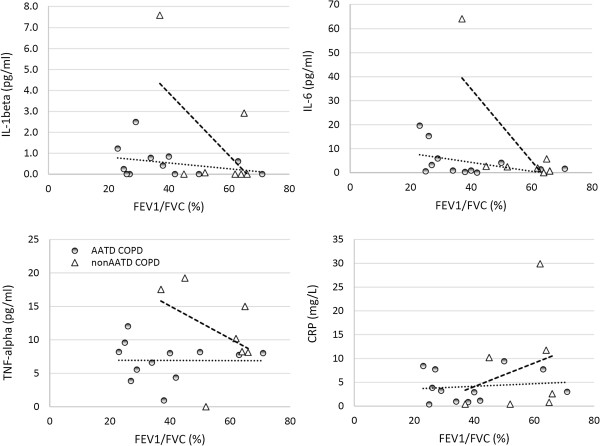
Correlation between circulating arterial cytokines and airway obstruction for AATD COPD patients (i.e. AATD + AUG and AATD-AUG groups shown as shaded circles) and for non-AATD COPD patients (open triangles). Dotted regression line reflect data for AATD COPD, whereas dashed regression line reflect data for non-AATD COPD.